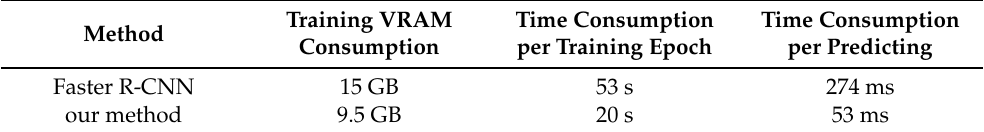
Table 5. Quantitative resource consumption and speed of two